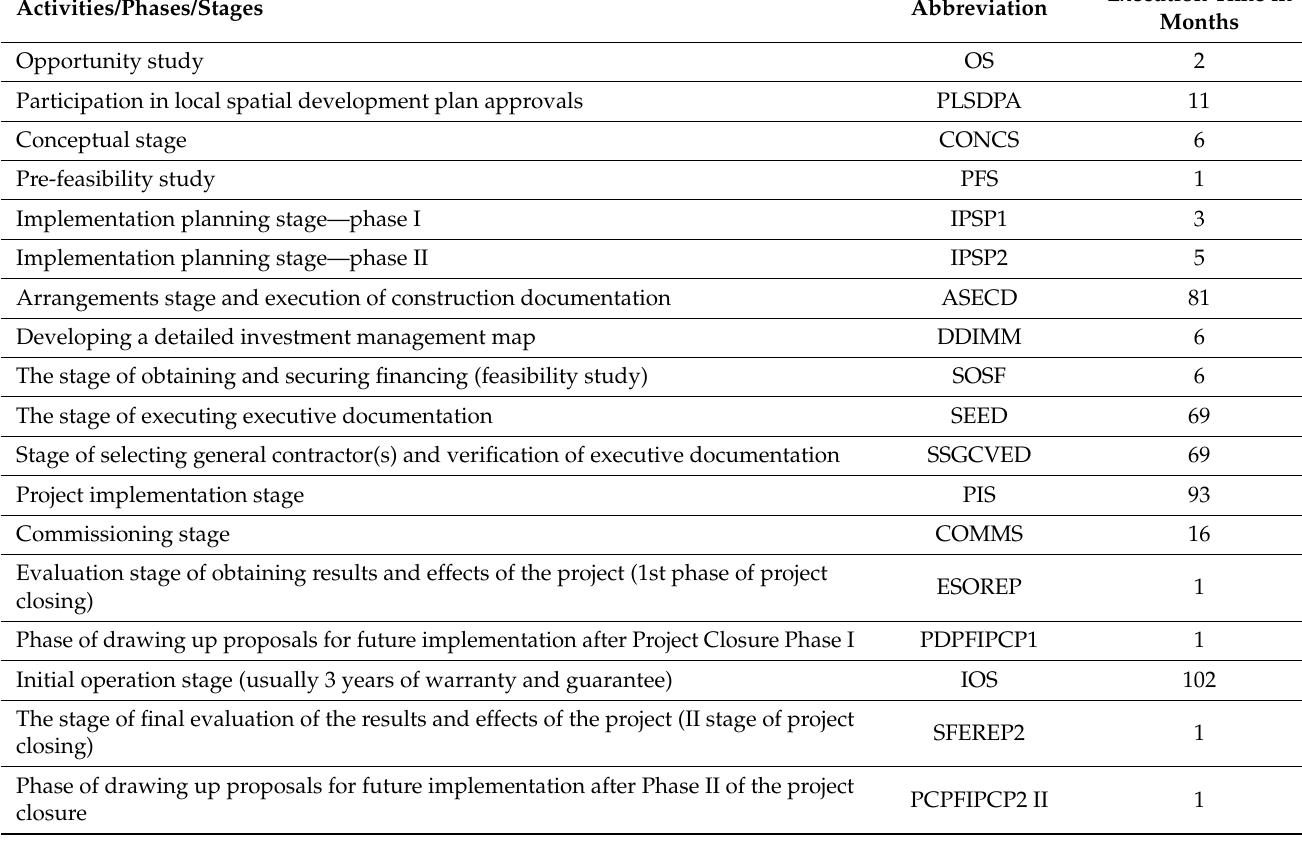
Table 2. Different stages of the Fort Bema investment process grouped in eight